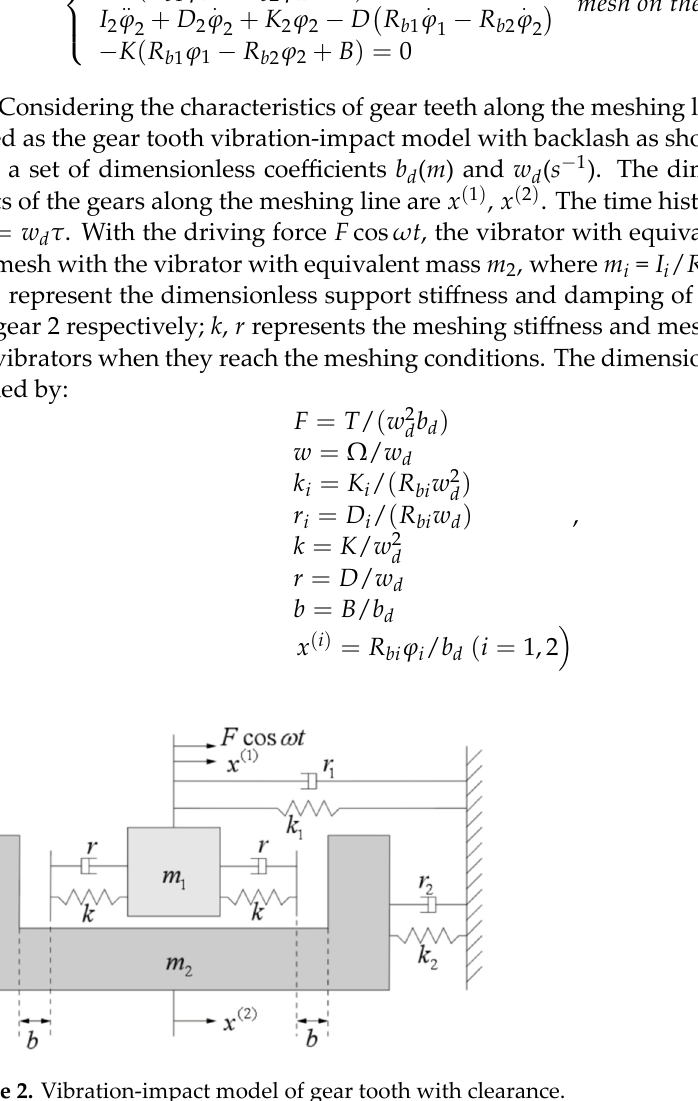
Figure 1. Diagram of gear pair with backlash.